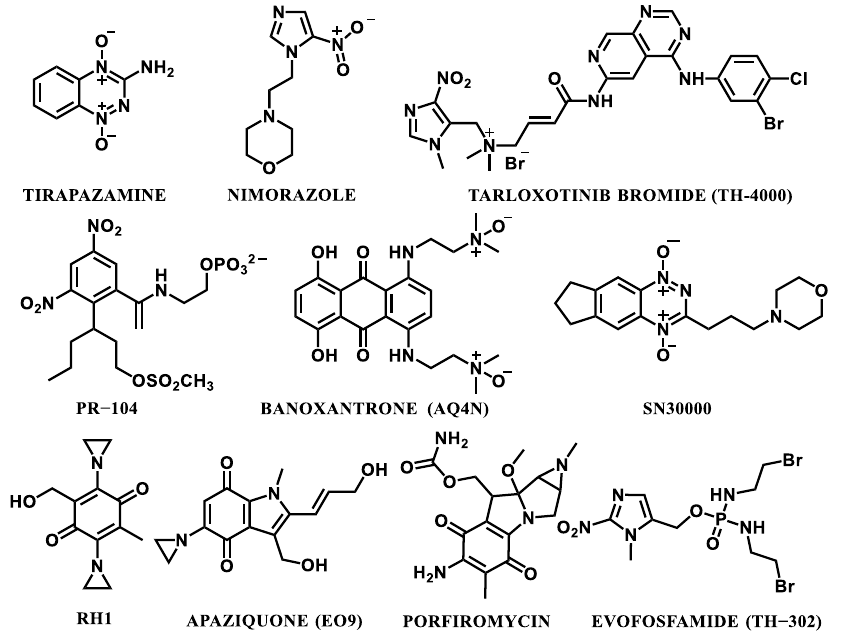
Figure 2. Structures of the selected hypoxia-activated prodrugs (HAPs) and hypoxic radiosensi- tizer: nimorazole. Table 1. Summary of clinical studies of HAPs (based on ref [38]).